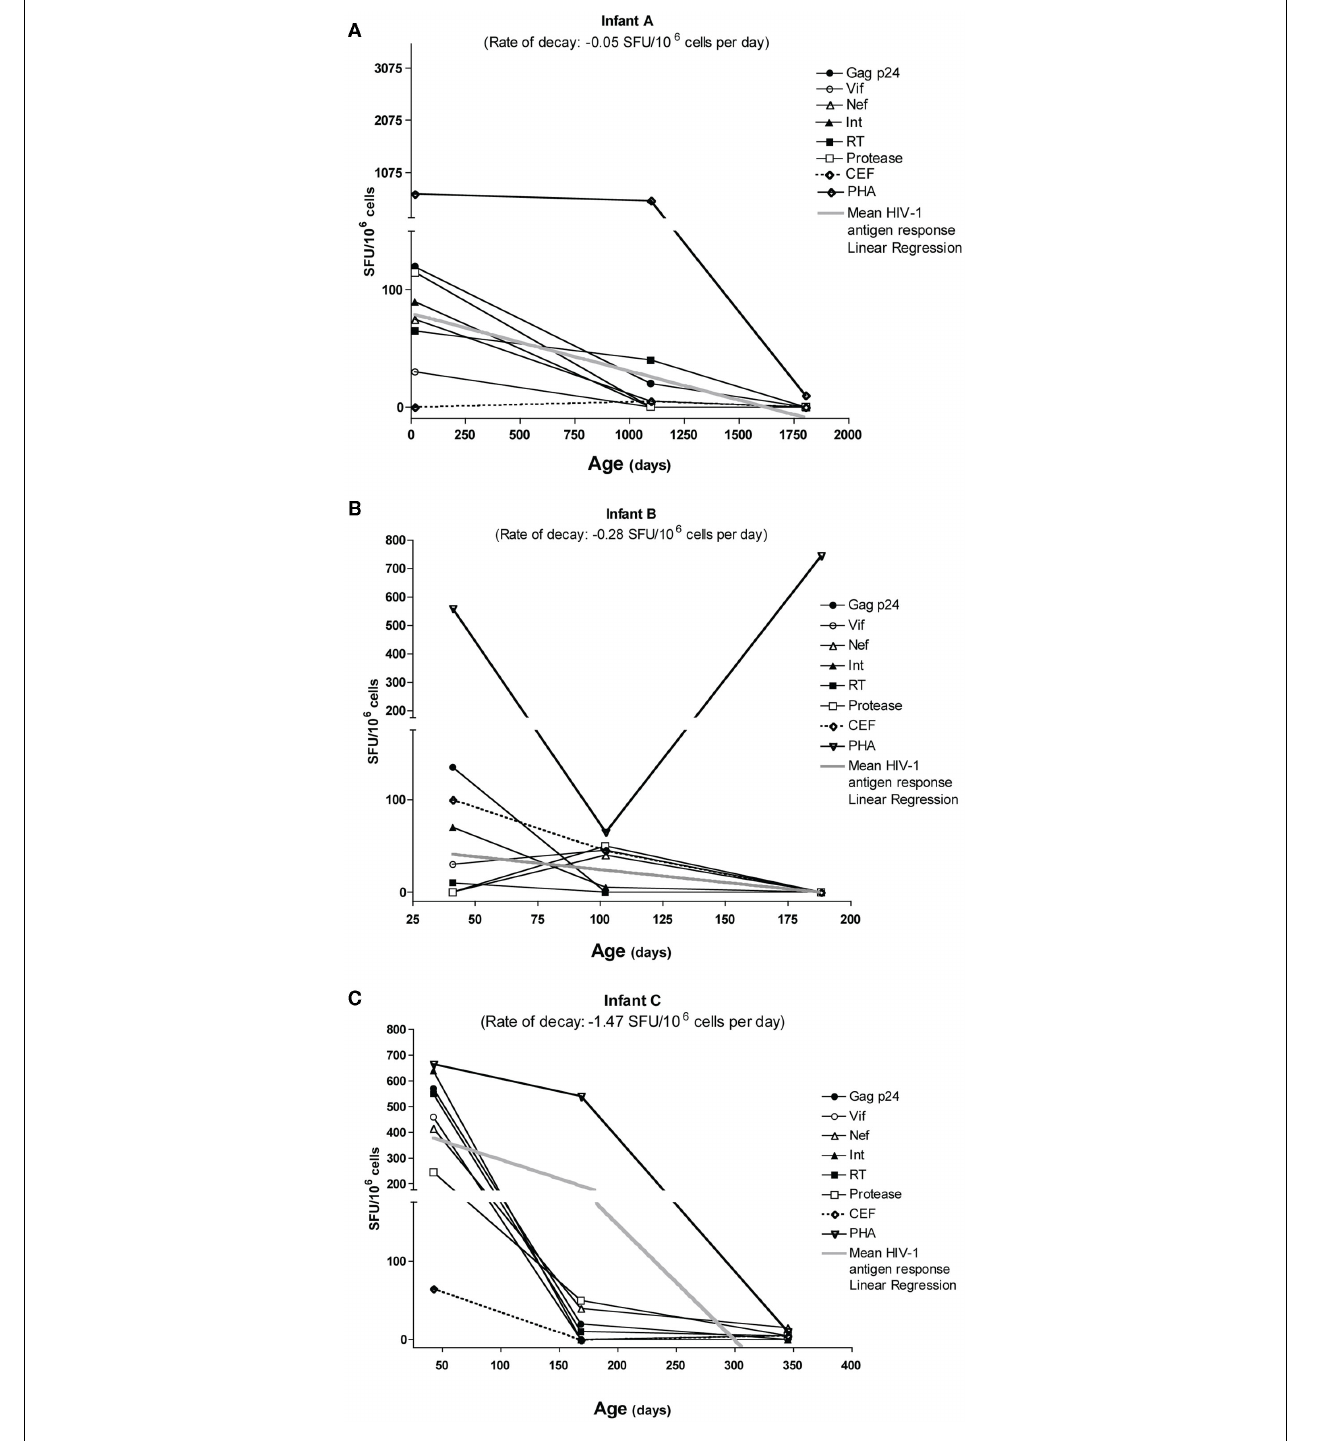
rates of decay between infants (A–C). From this, we calculated the mean antigen response decay rate of − 0.599SFU/10 6 cells per day, with a median half-life decay rate of 21.38weeks (13.39–115.8).